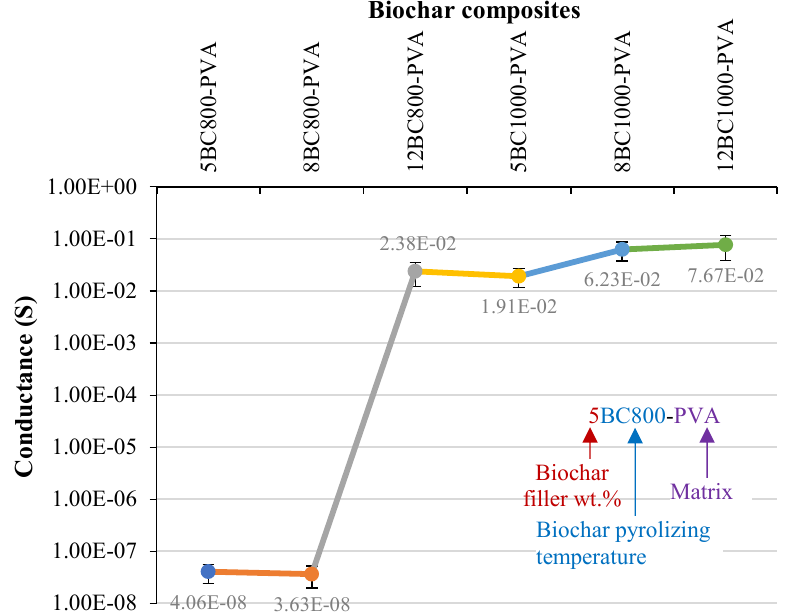
Figure 8. Effect of loading level of BC800 and BC1000 on electrical properties of biocomposite films.